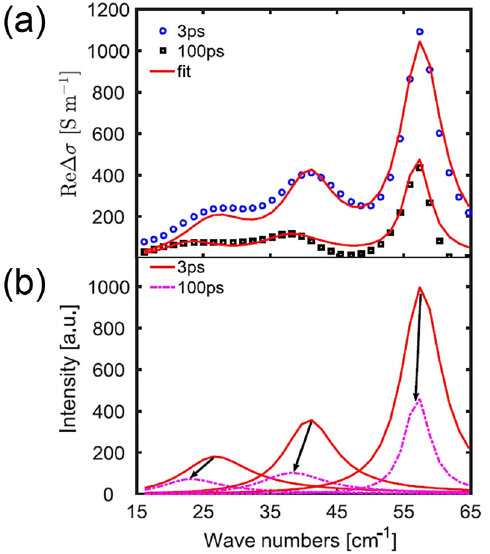
Figure 4: (a) Real part of the transient optical conductivity of CsPbBr 3 nanocrystalsatthetimedelayof3ps(bluedots)and100ps (black squares), respectively. The red lines are the Drude-Lorentz fi ttingcurvesoftheexperimentaldata.(b)RealpartoftheLorentzian fi t of at 3 ps (red solid lines) and 100 ps (magenta dashed lines). Reproduced with permission [95]. Copyright 2019, American Physical